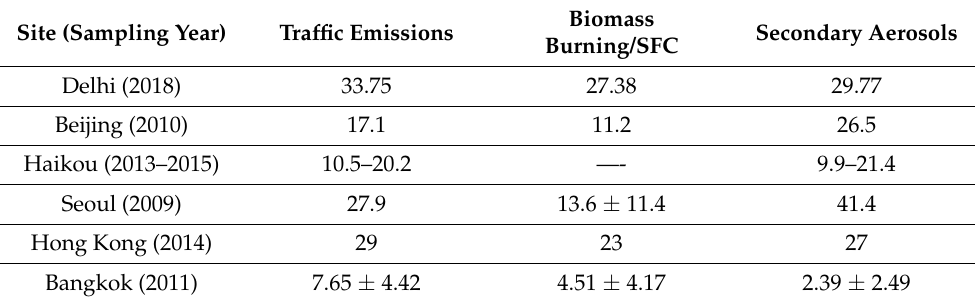
Table 3. The fractional contributions (in%) of three major sources to PM 2.5 at different urban sites in Asia (the details are in the main